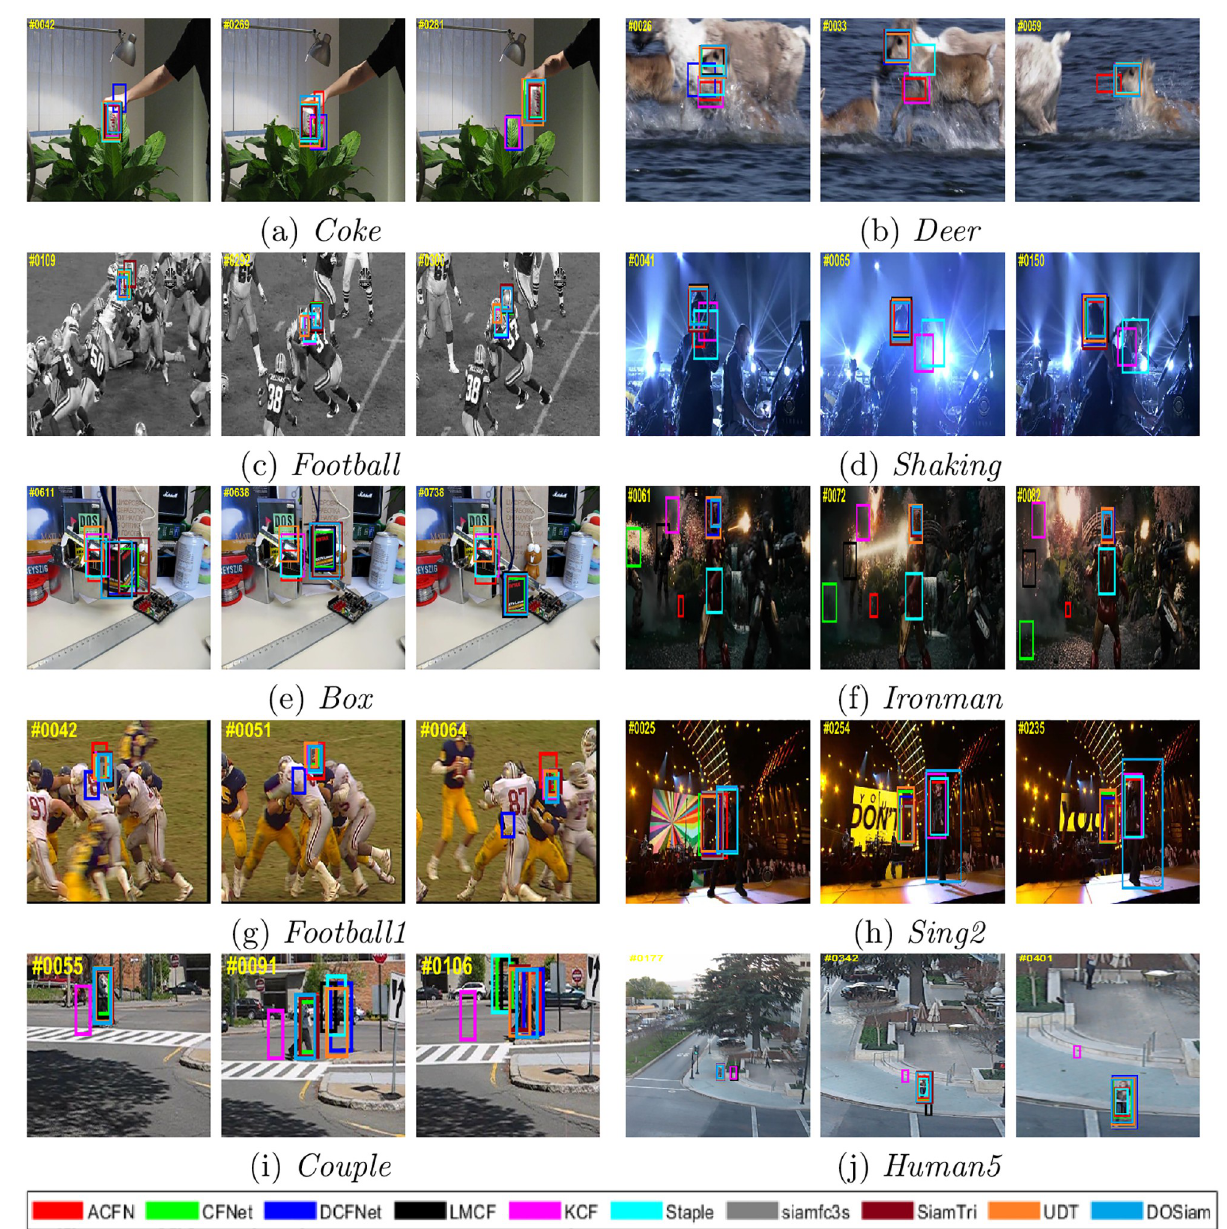
Fig 3. Comparison with state-of-the-art tracking algorithms. The tracker DOSiam gets best tracking results in challenging environments of fast motion, scale variation, motion blur, in-plane and out-plane rotations.